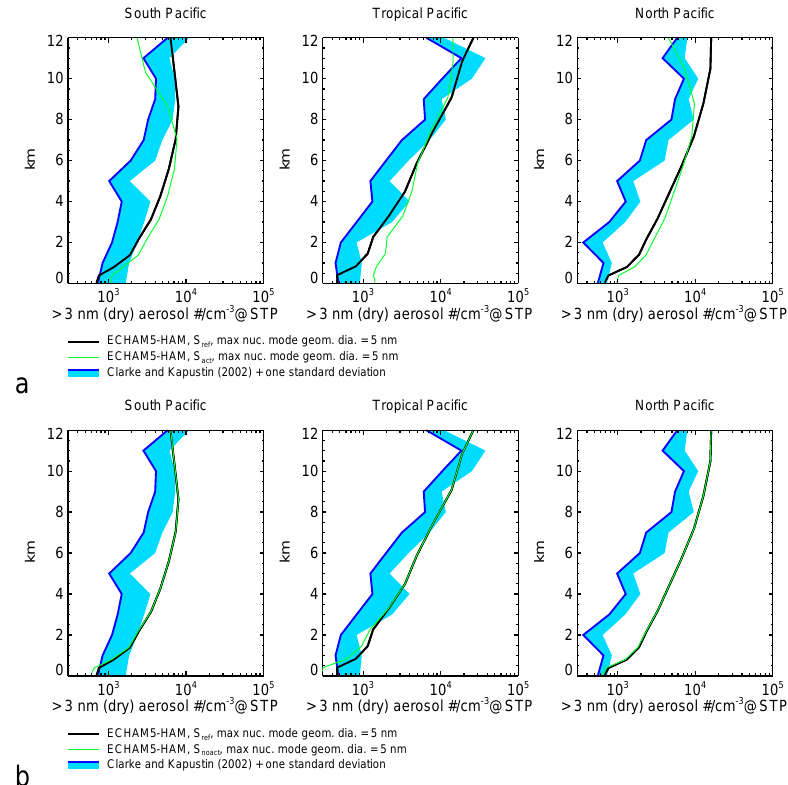
Fig. 5. Comparison of annual mean ultrafine aerosol concentrations from different simulations with observations in three regions of the Pacific Ocean: (a) S ref (black), simulation S act (green). (b) S ref (black), simulation S noact (green). A maximum geometric mean diameter of 5nm for the nucleation mode in the M7 aerosol microphysics module was used here.